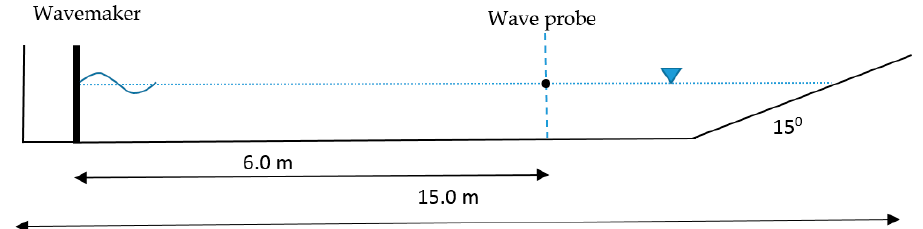
Figure 19. Schematic view of numerical wave tank for 3-D validation. Table 7. The numerical setting in DualSPHysics (3D). Kernel function Wendland Time step algorithm Symplectic